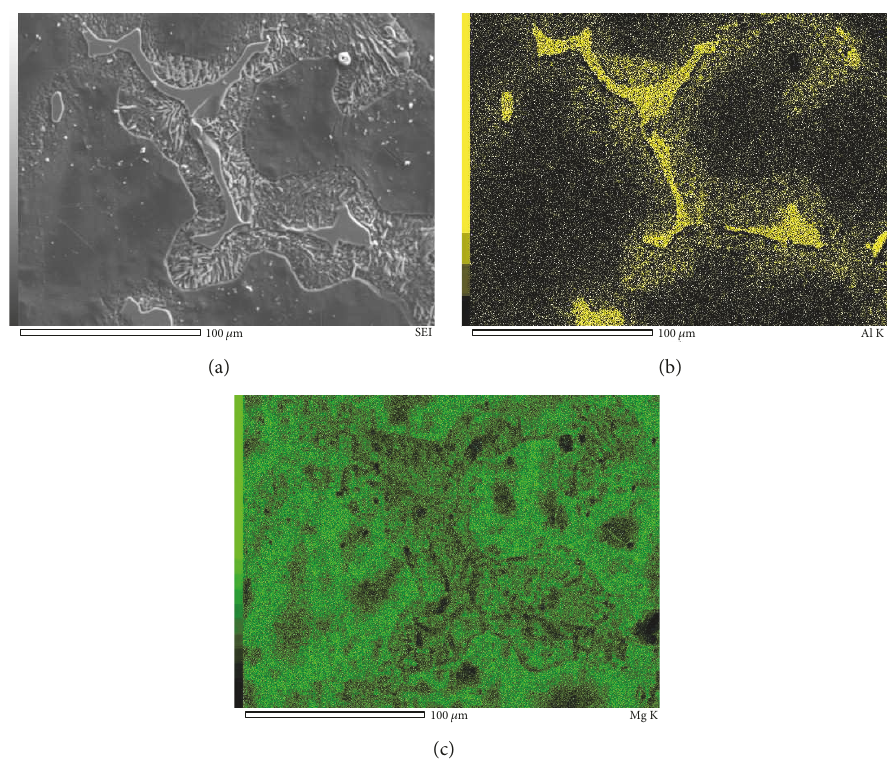
Figure 5: (a) SEM micrograph of the AZ91D alloy; (b) EDS mapping analysis for Al; (c) EDS mapping analysis for